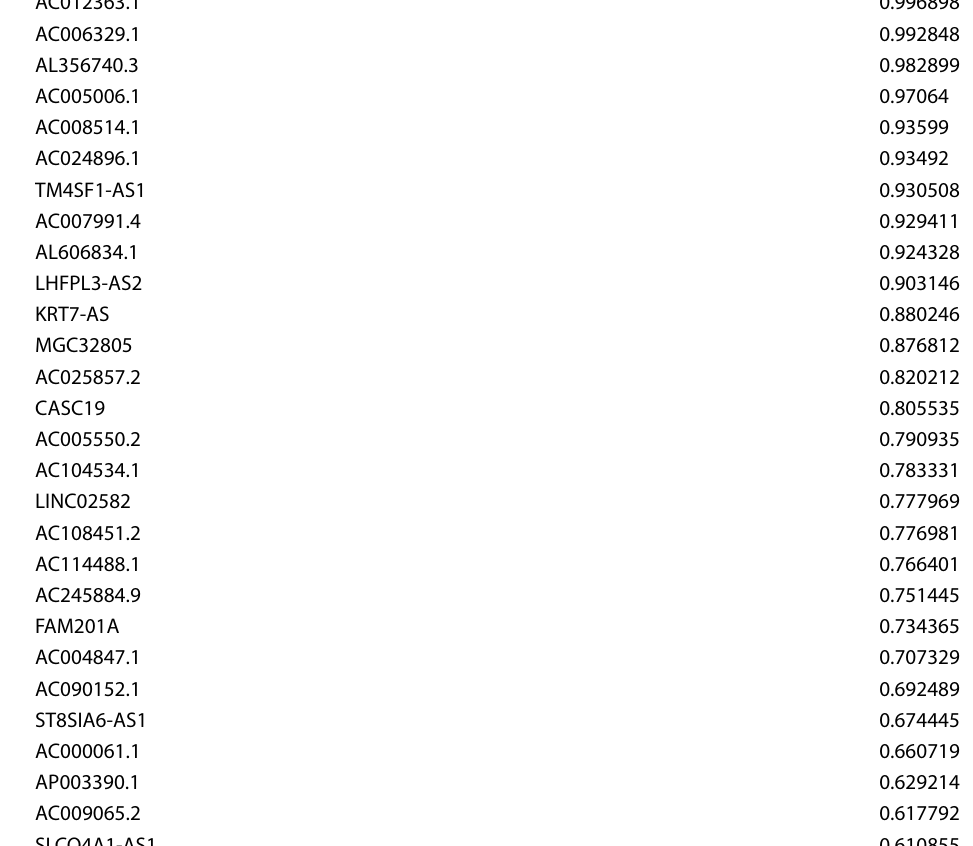
Table 1 The survival of DE-IRlncRNAs in the grey